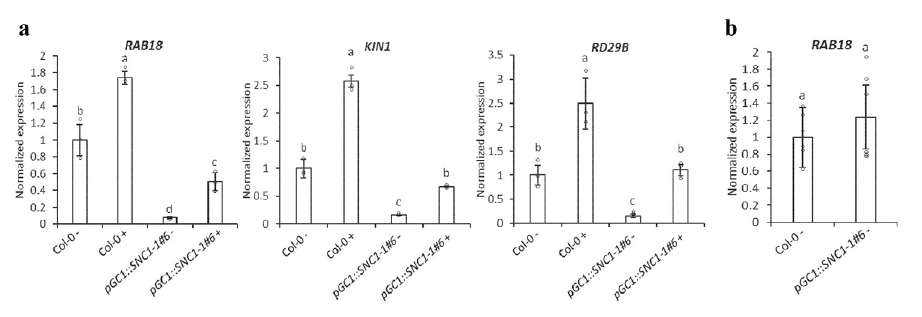
Fig 9. ABA signaling in enriched guard cells assayed by expression of ABA responsive genes. Shown is the transcript abundance of RAB18 , KIN1 , and RD29B assayed by qPCR in enriched guard cells ( a ) and RAB18 in whole leaves ( b ) in Col-0 and pGC1 :: SNC1-1 line with (+) or without (-) Pst DC3000 infection. Total RNAs were isolated from purified guard cells and whole rosette leaves of 5-week-old plants. Results were from one of the two independent experiments. The expression was normalized to the expression of a reference gene ACTIN in the guard cells of Col-0 without Pst DC3000 infection. Values are arithmetic means ± S.E., different letters indicate statistically significant differences between indicated plant lines (p < 0.05, based on one-way ANOVA followed by Student’s t test).